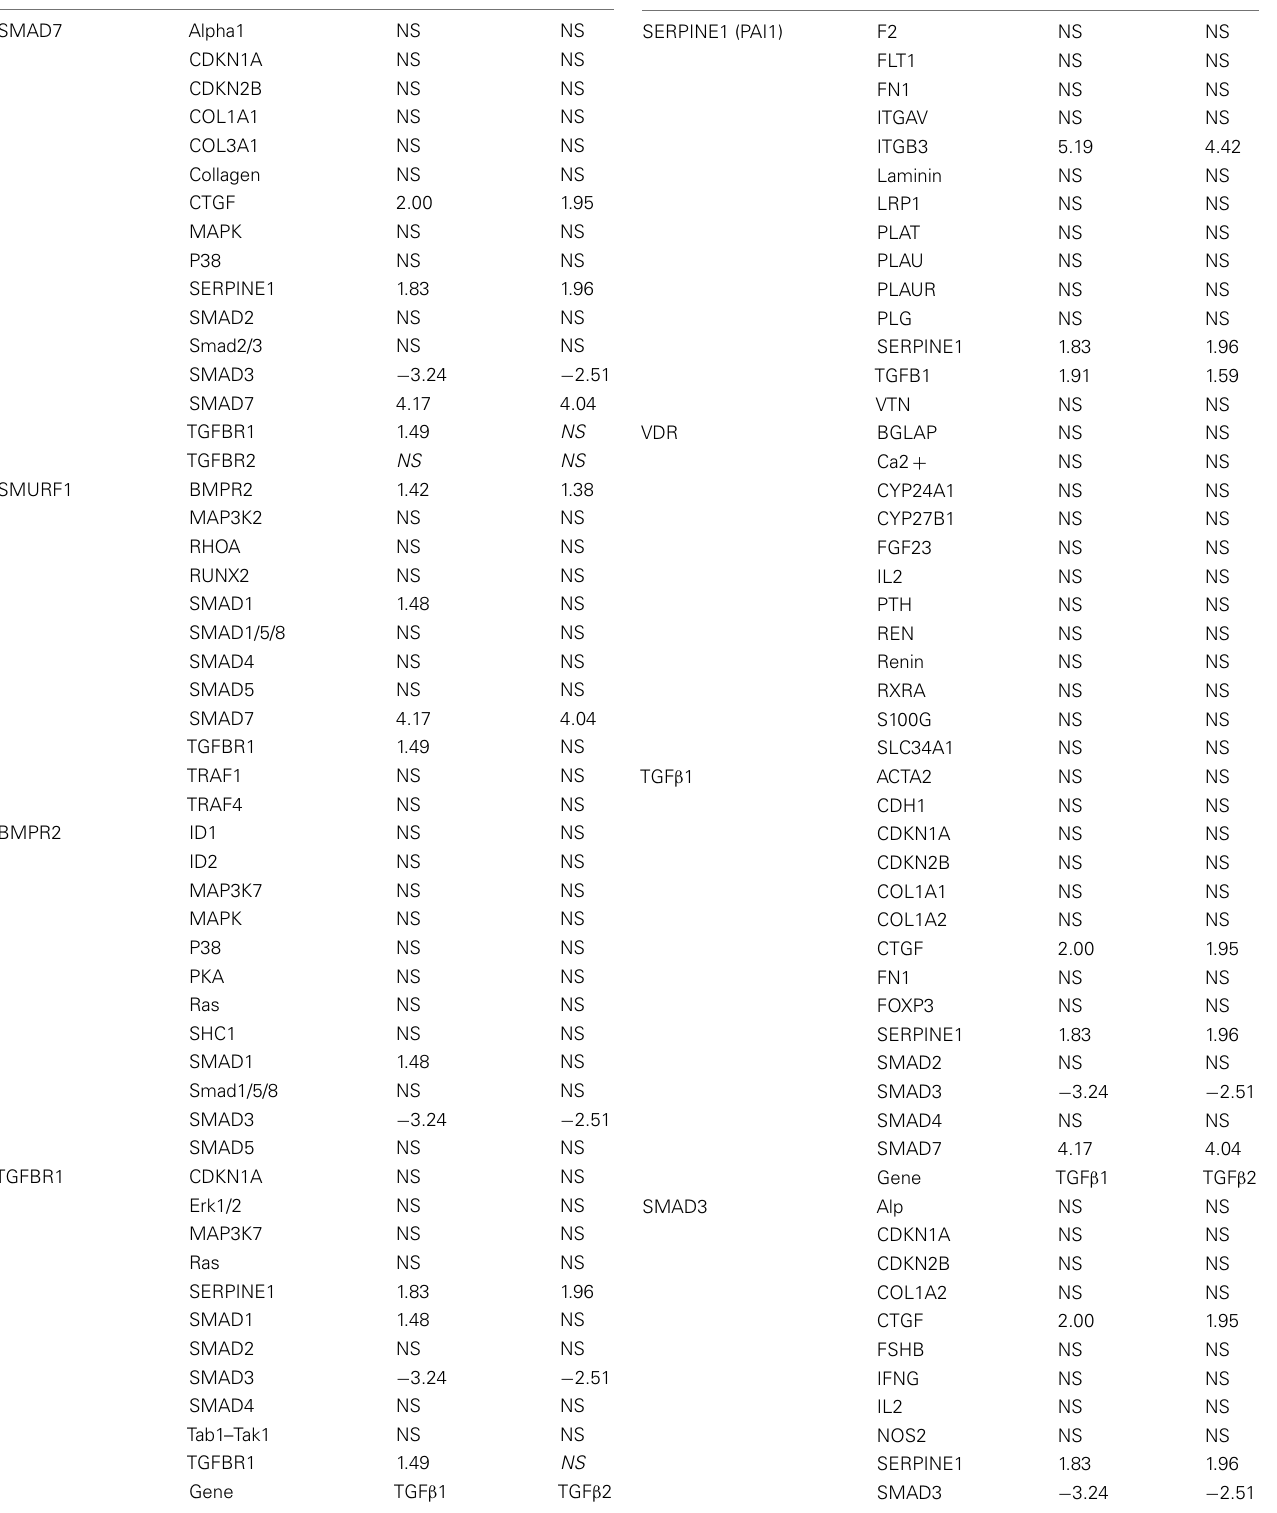
TableA4 |The full list of genes regulated by differentially expressed TGF β signaling molecules and their level of altered